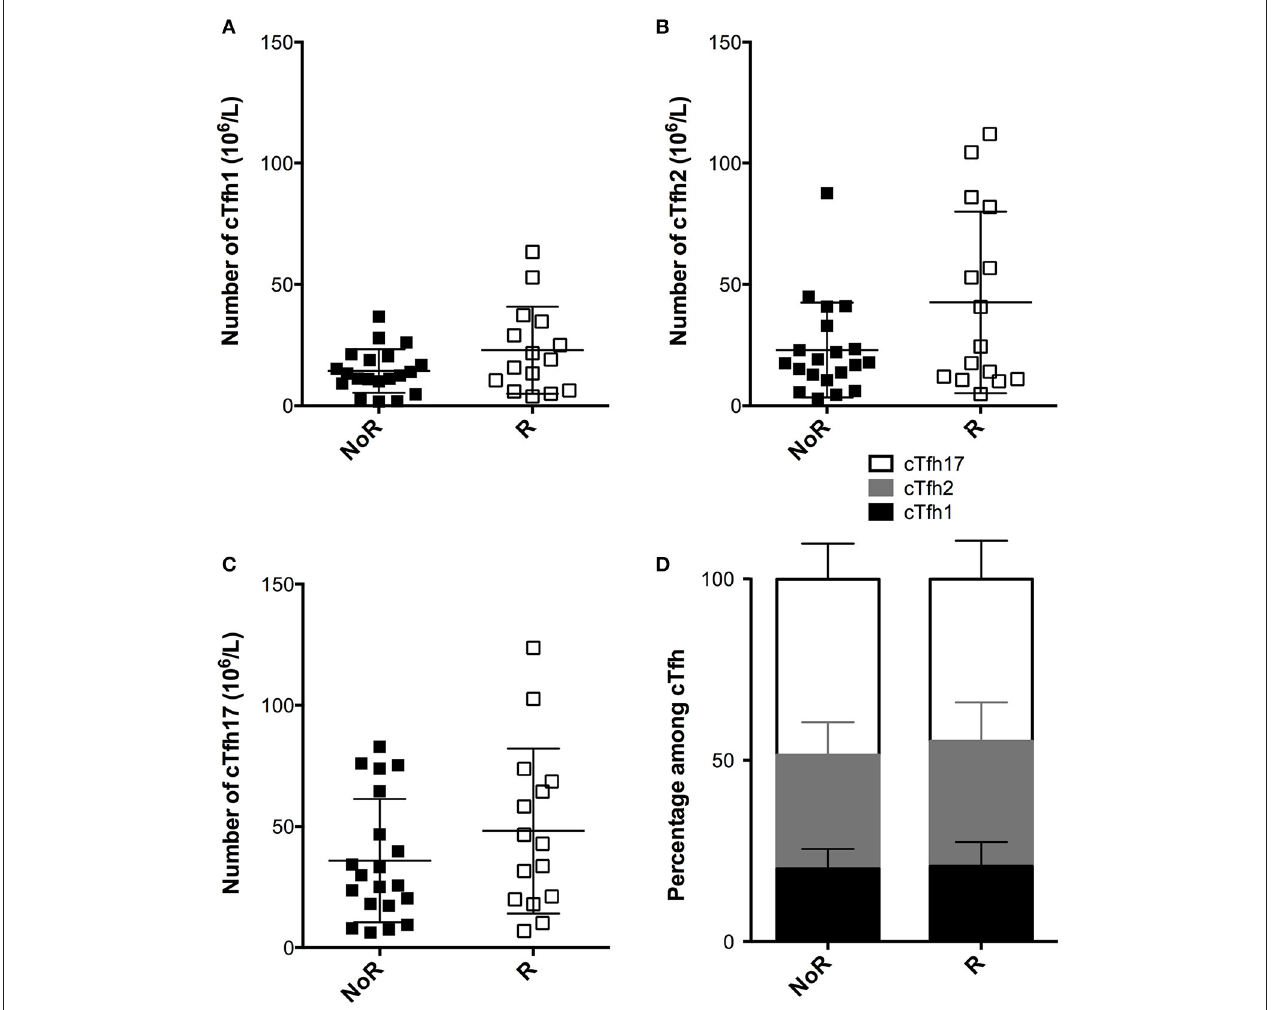
FIGURE 6 | Comparison of the static profile of cTfh of responders and non-responders to A/Switzerland hemagglutinin. (A–C) PBMC of transplant patients were collected just before vaccination. The number cTfh of each of the three subsets ( A : cTfh1; B : Tfh2; C : cTfh17) was enumerated by flow cytometry. Data from transplant patients that had developed (Responders, R; n = 15; open square) or not developed (non-responders, NoR; n = 20; black square) antibodies against Switzerland hemagglutinin are compared. Each symbol represents a patient, mean ± SD is indicated. (D) The proportion (mean ± SD) of each of the three subsets of cTfh is compared between the two groups. Mann-Whitney